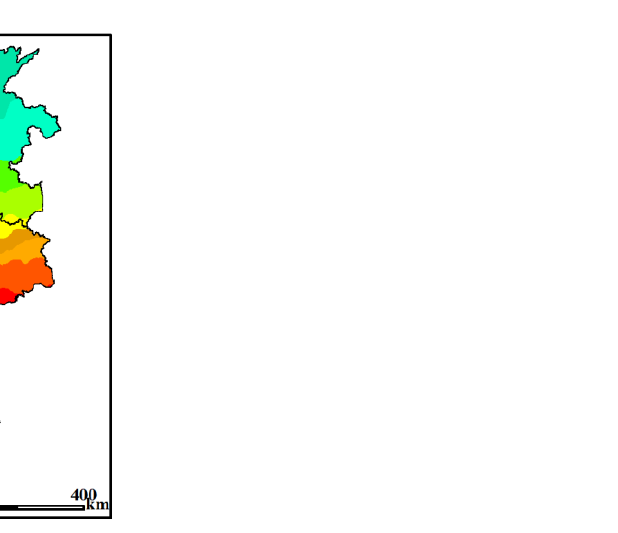
Figure 7. Water simulation results of topographic drop in Central China at various scales.